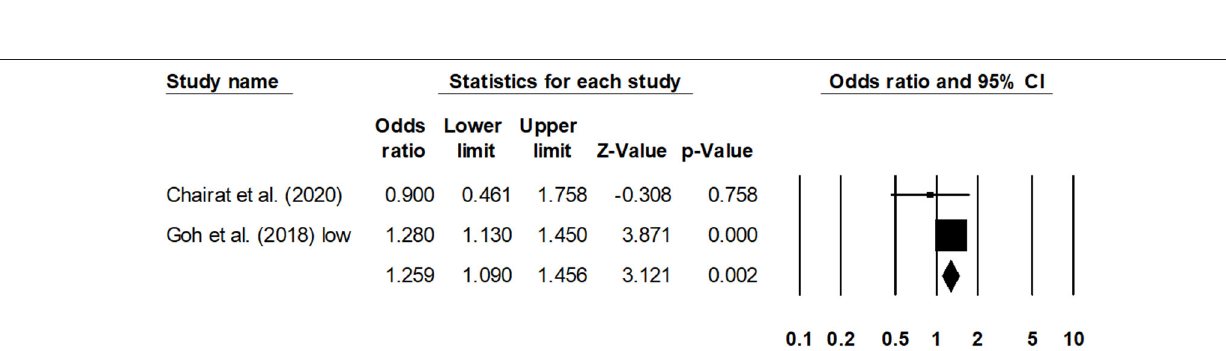
FIGURE 5 | Forest plot for studies evaluating the overall 1-year overall mortality outcome. The adjusted odds ratios are presented as black boxes, whereas 95% confidence intervals are presented as whiskers. A negative odds ratio represents a reduction in the risk of mortality in heart failure patients with anemia, whereas the positive odds ratio represents an increase in the risk of mortality in heart failure patients with anemia.